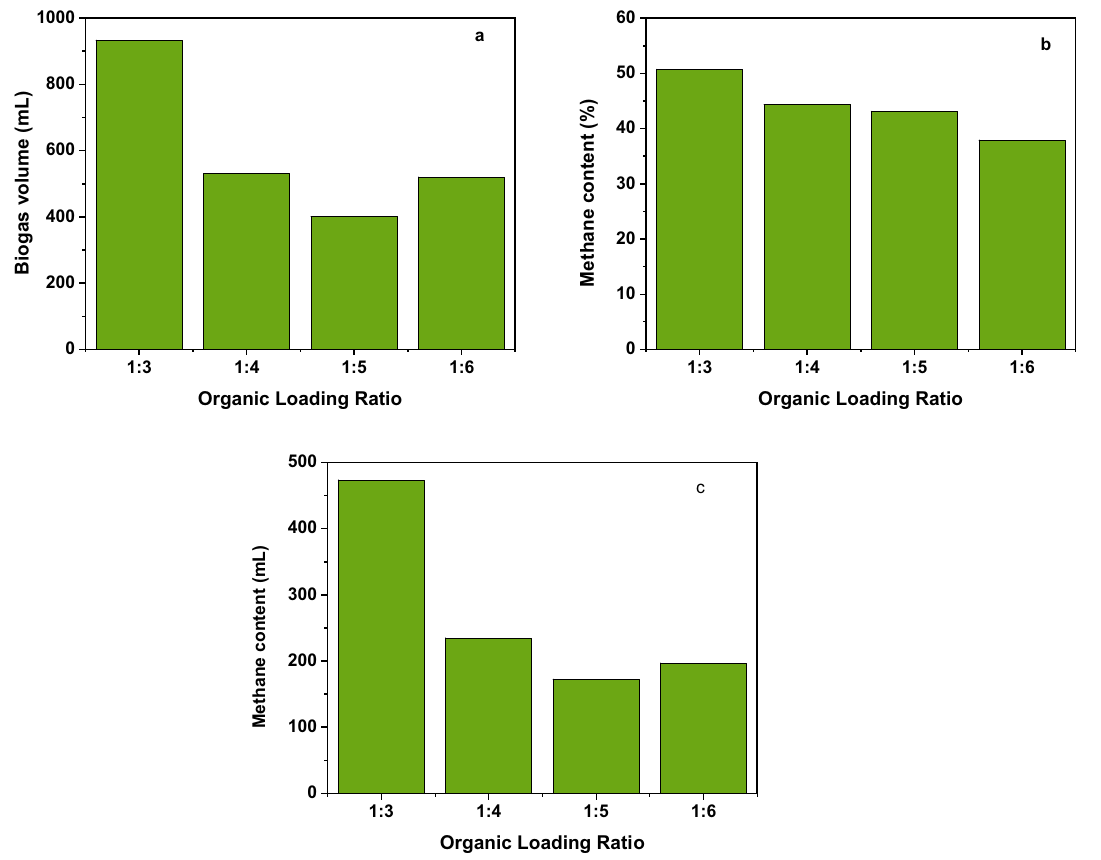
Figure 4. ( a ) Biogas production (mL) as a function of organic loading ratio, ( b ) methane content (%) as a function of organic loading ratio, and ( c ) methane content (mL) as a function of organic loading